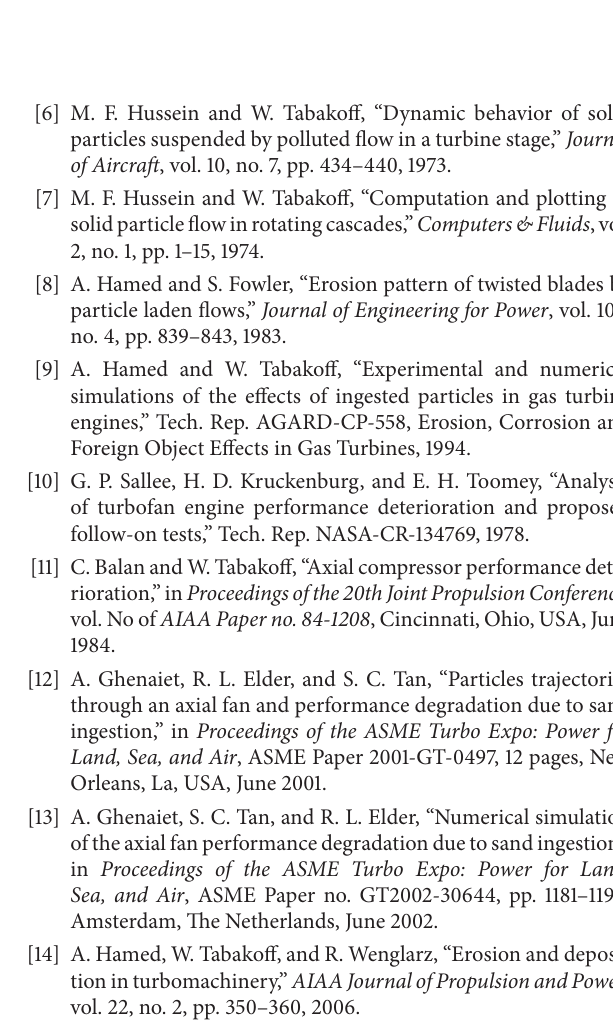
Figure 16: Eroded profiles after one hour of sand ingestion of a concentration (500mg/m 3 ): (a) 𝑅75 profile; (b) tip profile (dashed line is the initial profile and solid line is the eroded